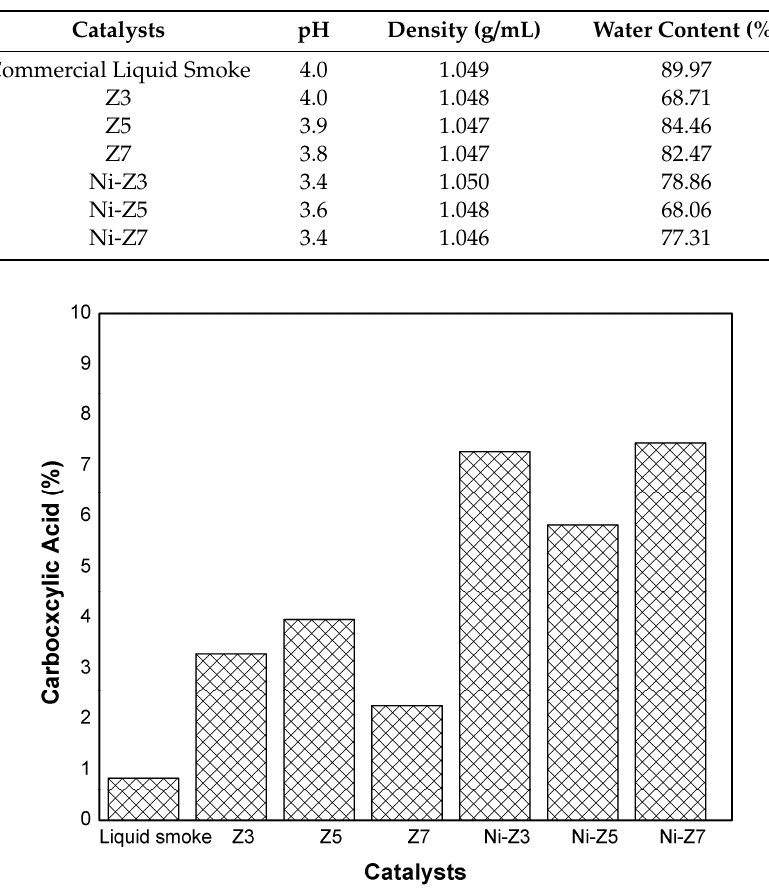
Figure 8. Carboxylic acid percentage in liquid smoke HDO product.